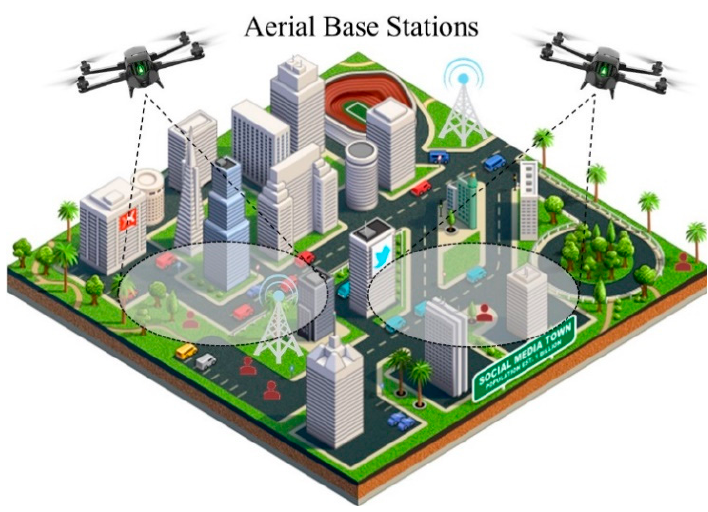
Figure 2. Aerial base stations providing 5G services to users at ground level in an urban environ- ment.